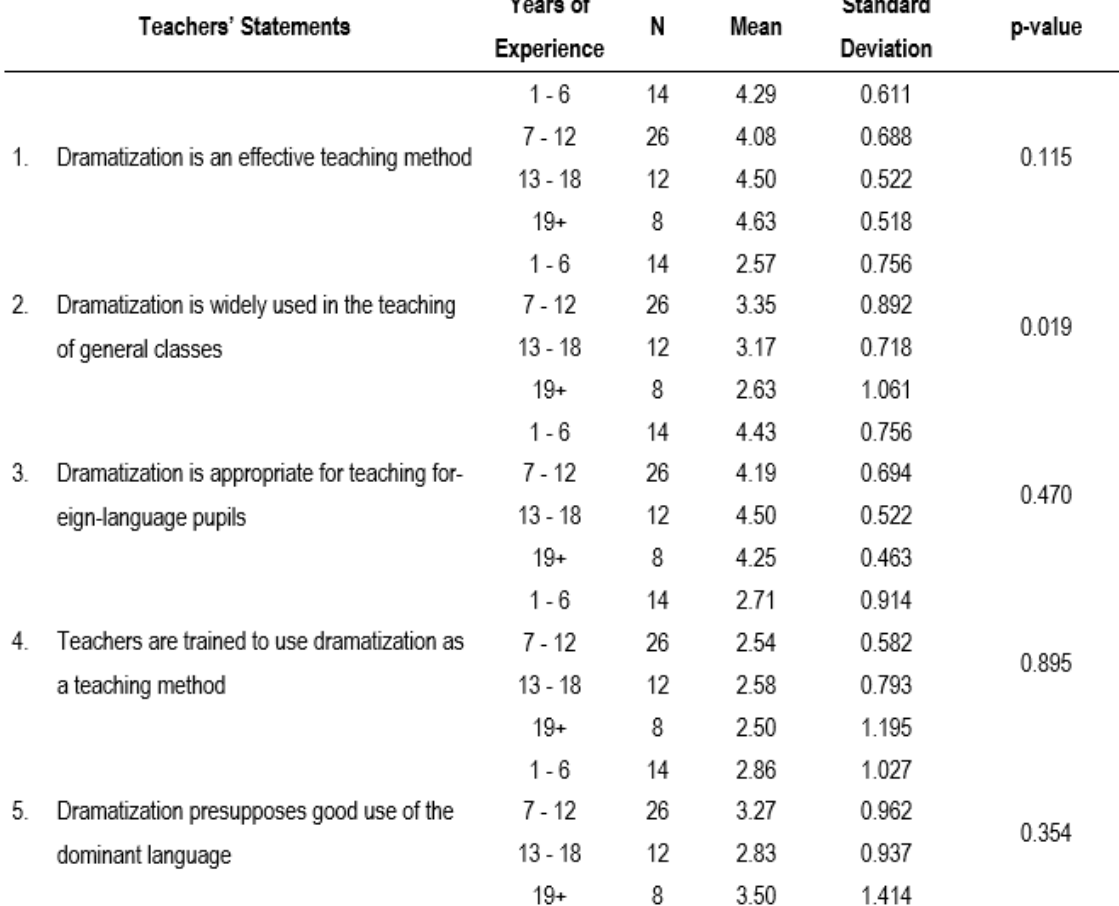
Comparison of teachers’ views based on years of experience, according to non-parametric Kruskal- Wallis statistical